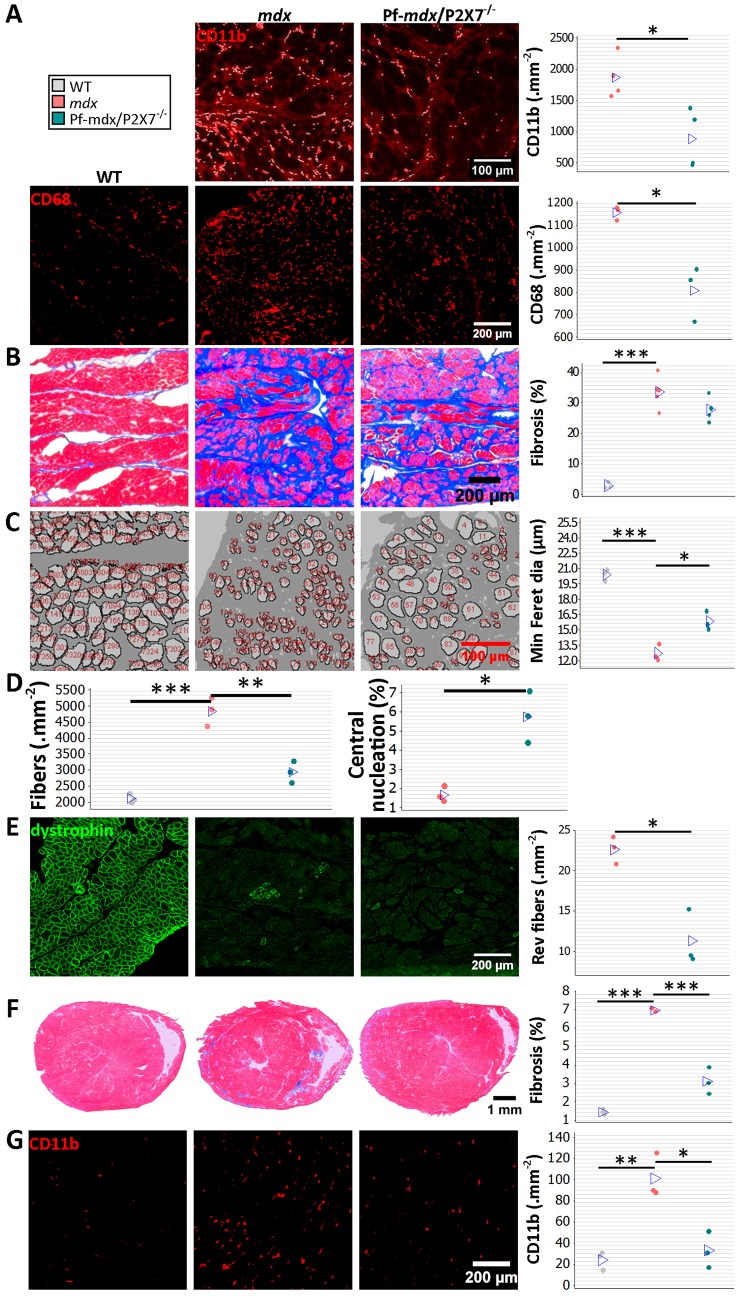

P2RX7 ablation continues to reduce dystrophic pathology in 20-mo-old diaphragm and heart.(A) Representative immunofluorescence micrographs (left) and enumeration of CD11b- and CD68-expressing cells in 20-mo-old diaphragms showing reduced numbers of infiltrating leukocytes (CD11b t-test, t = 3.68, df = 6, p = 0.015) and macrophages (CD68+
t-test, t = 4.73, df = 4, p = 0.009) in Pf-mdx/P2X7−/− compared to mdx diaphragms. (B) Trichrome staining (left) and its average intensity in 20-mo-old diaphragms demonstrating no increase in fibrosis in Pf-mdx/P2X7−/− over mdx mice (ANOVA, F = 60.32, df = 2, n = 5, 5, 3, p < 0.001; Tukey’s test, Pf-mdx/P2X7−/− versus mdx, p = 0.095; permutation analysis, Pf-mdx/P2X7−/− versus mdx, F = 4.47, p = 0.095). (C) Representative ImageJ output masks from morphometric analyses of diaphragm fibers (left) demonstrating the increased average minimum Feret diameter in mdx/P2X7−/− compared to mdx diaphragms (ANOVA, F = 75.17, df = 2, n = 3, p < 0.001; Tukey’s test, Pf-mdx/P2X7−/− versus mdx, p = 0.006; permutation analysis, Pf-mdx/P2X7−/− versus mdx, F = 20.01, p = 0.099). (D) Graphs showing a lower total number of diaphragm fibers per unit area in Pf-mdx/P2X7−/− versus mdx mice (left; ANOVA, F = 52.77, df = 2, n = 3, p < 0.001; Tukey’s test, Pf-mdx/P2X7−/− versus mdx, p = 0.001; Pf-mdx/P2X7−/− versus WT, p = 0.051) and the increased proportion of C/N fibers (right; t-test, t = 5, df = 4, p = 0.008). (E) Dystrophin immunofluorescence in representative transverse sections of 20-mo-old diaphragms showing the typical staining (green signal) in dystrophin-positive muscles and clusters of revertant dystrophin-positive fibers in dystrophic samples. The data show significantly fewer revertant fibers in 20-mo-old Pf-mdx/P2X7−/− than in mdx diaphragms (t-test, t = 5.12, df = 4, p = 0.007). (F) Representative trichrome staining (left) of whole hearts from 20-mo-old mice showing a significant decrease in cardiac muscle damage (histological lesions) and average area of fibrosis (blue signal in trichrome staining) in Pf-mdx/P2X7−/− versus mdx mice (ANOVA, F = 166.29, df = 2, n = 4, 3, 3, p < 0.001; Tukey’s test, Pf-mdx/P2X7−/− versus mdx, p < 0.001). (G) Representative examples of CD11b+ leukocyte marker staining (left; red immunofluorescence) and infiltrating cell counts demonstrating fewer infiltrations in Pf-mdx/P2X7−/− compared to mdx hearts (ANOVA, F = 19.65, df = 2, n = 3, p = 0.002; Tukey’s test, Pf-mdx/P2X7−/− versus mdx, p = 0.005). *p < 0.05, **p < 0.005, ***p < 0.001.